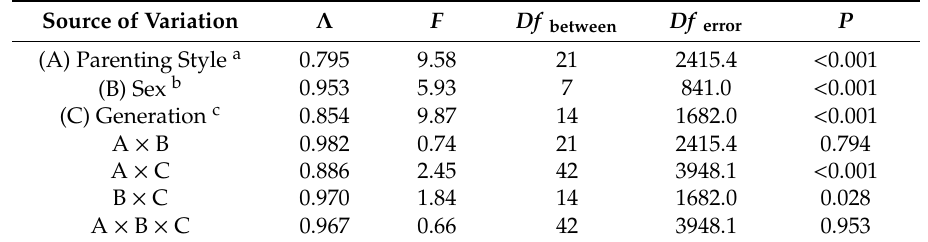
Table 3. Multivariate analysis of variance (MANOVA) factorial (4 a × 2 b × 3 c ) for psychosocial adjustment (self-concept and